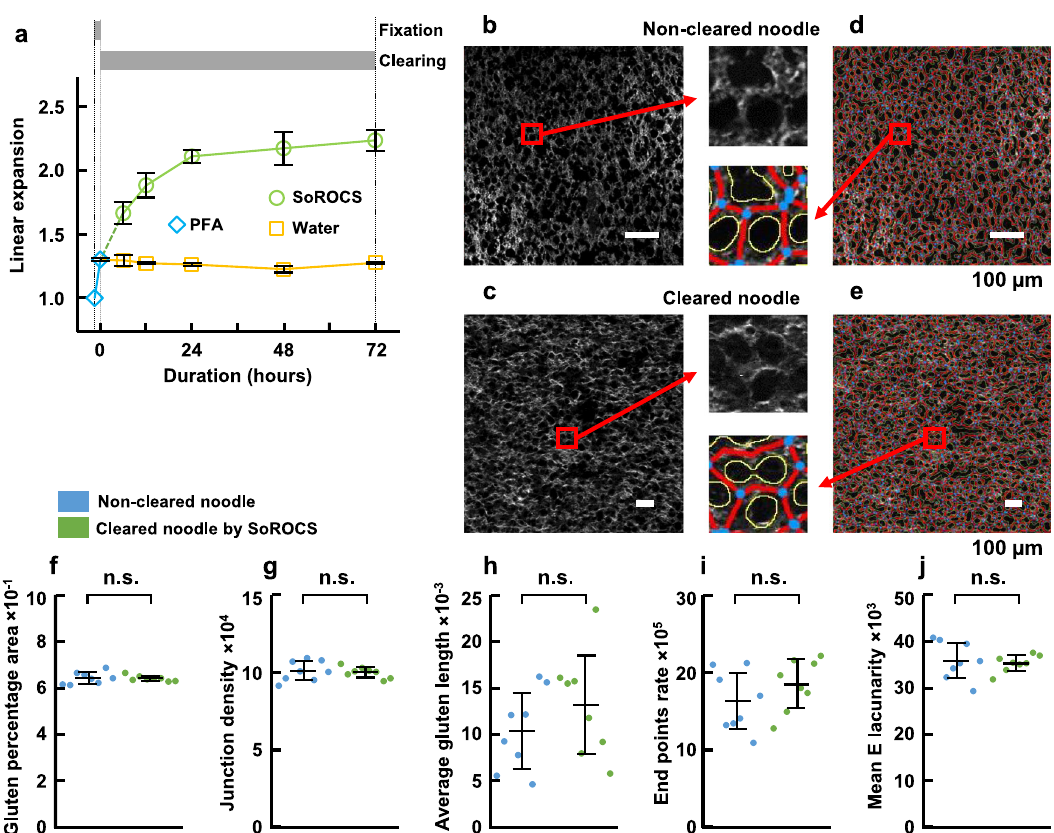
Fig. 2 Expansion characterisation during clearing. a Linear expansion curves in the fi xation process (light blue) and clearing process using water (yellow) or SoROCS (green). Data are presented as mean values ± SD ( N = 3 independently prepared noodle samples). b CLSM image of gluten in the non-cleared noodle sample section, which was mechanically sliced using a cryostat. c 2PEM image of gluten in the cleared noodle by SoROCS. d , e Image after protein network analysis with AngioTool (blue points: junction (branching points), red lines: gluten skeleton, yellow line: gluten outlines). An enlarged image of the section delineated with a red square is shown at the tip of the red arrow in ( b – e ). Scale bars indicate 100 µ m ( b – e ). Comparison of variables calculated by AngioTool for non-cleared noodles (blue) and cleared noodles (green): gluten percentage area ( f ), junction density ( g ), average gluten length ( h ), end points rate ( i ) and mean E lacunarity ( j ). Noodle samples were prepared four times independently ( N = 4), and two different section samples were prepared from each noodle preparation ( N = 2). One of these eight different images obtained using CLSM and 2PEM is shown in ( b , c ), respectively. f – j Date are presented as mean values± SEM. The SEM is calculated from the mean values for N = 2. P values were calculated using the Student ’ s two- tailed unpaired t test ( f : P = 0.92, g : P = 0.76, h : P = 0.38, i : P = 0.31, j : P = 0.76). All variables show no signi fi cant difference at the P = 0.05 level. Source data underlying ( a , f – j ) are provided as a Source Data fi